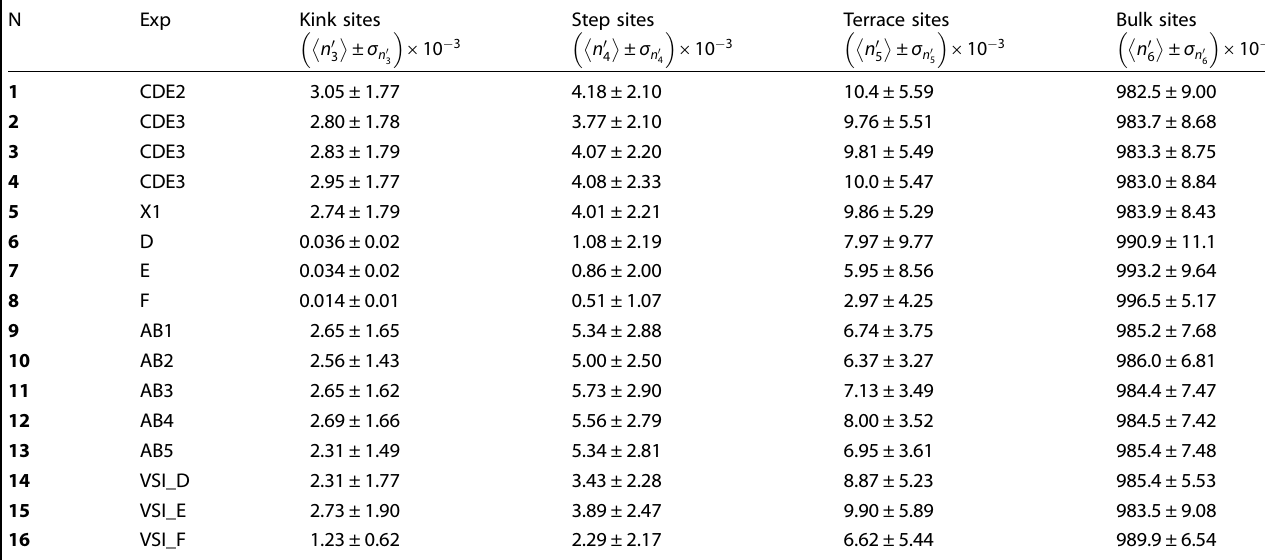
Table 7. Average and related standard deviation for the solid concentration of the different